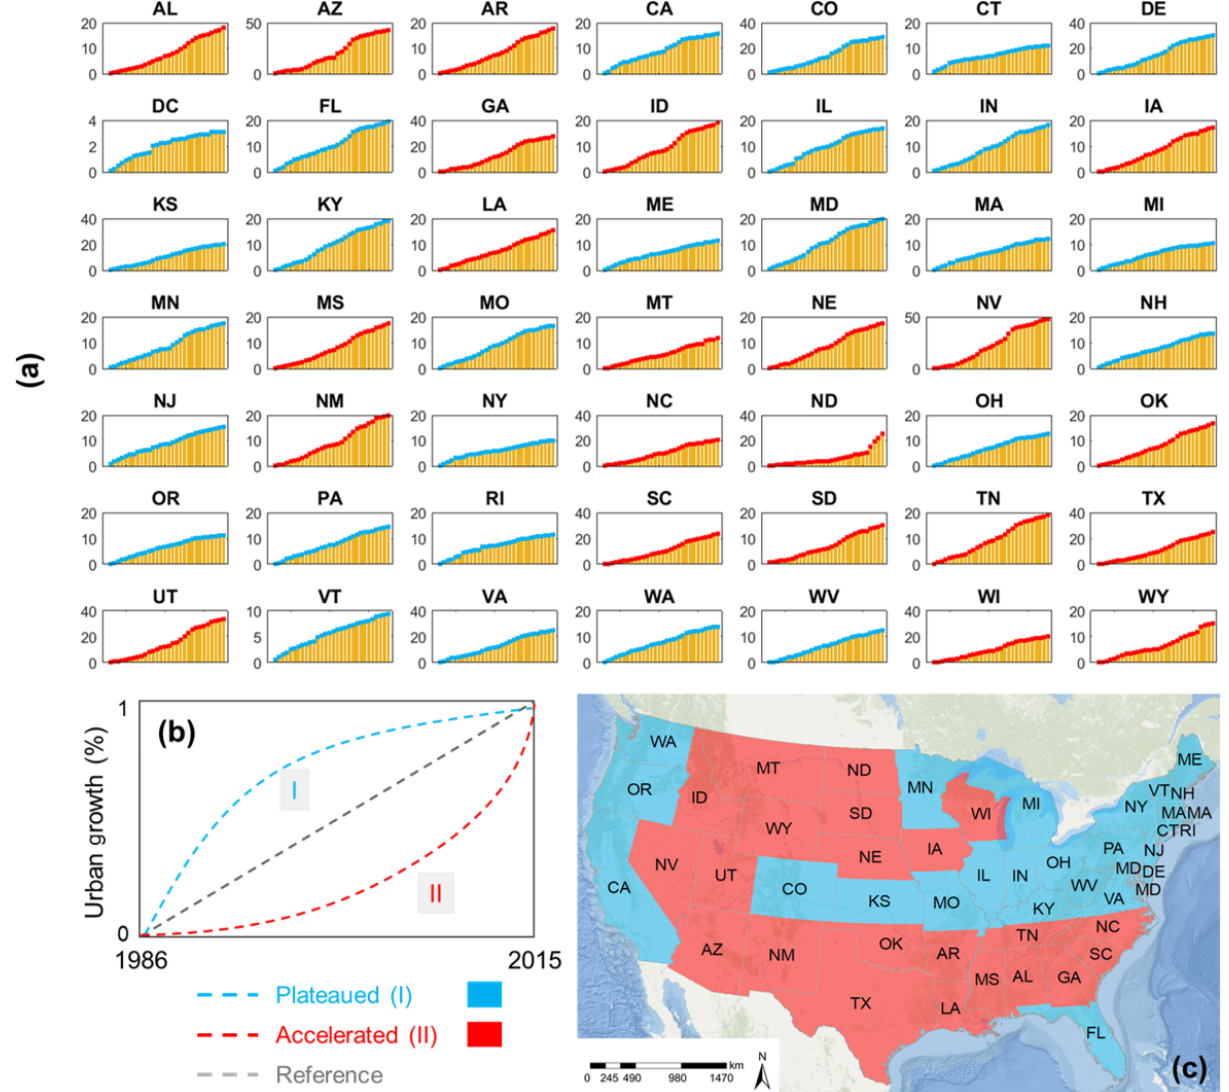
Figure 7. Urban area growth patterns over the past three decades of each state in the US (a) , the proposed conceptual model (b) , and the classified urban area growth types (c) (Basemap data© 2019